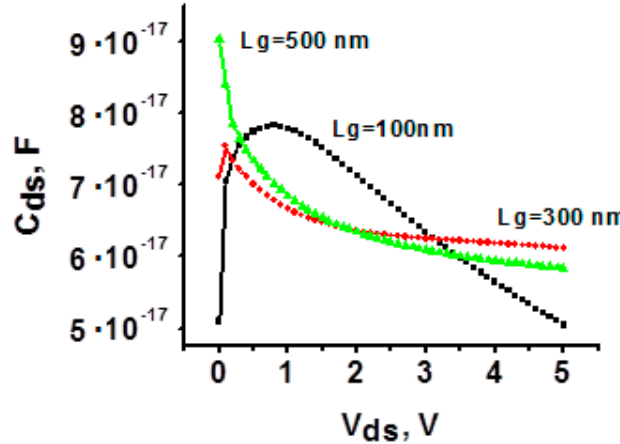
Figure 2. C–V dependences of drain–substrate junction at different gate lengths of MOSFET.